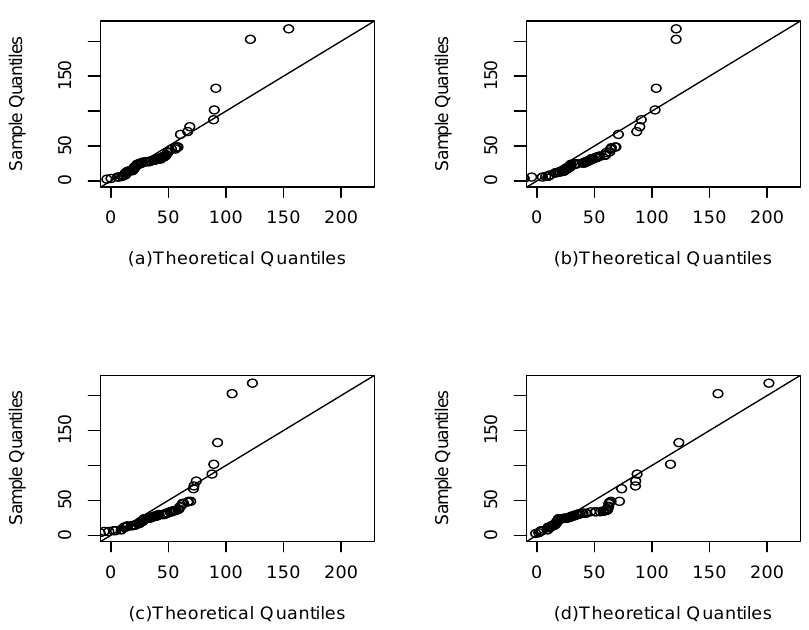
Figure 8. QQ plot for the neodymium concentration data set. The modified Laplace density ( a ), expo- nentially modified logistic density ( b ), exponentially modified Gaussian density ( c ), and exponentially modified Laplace density ( d ).